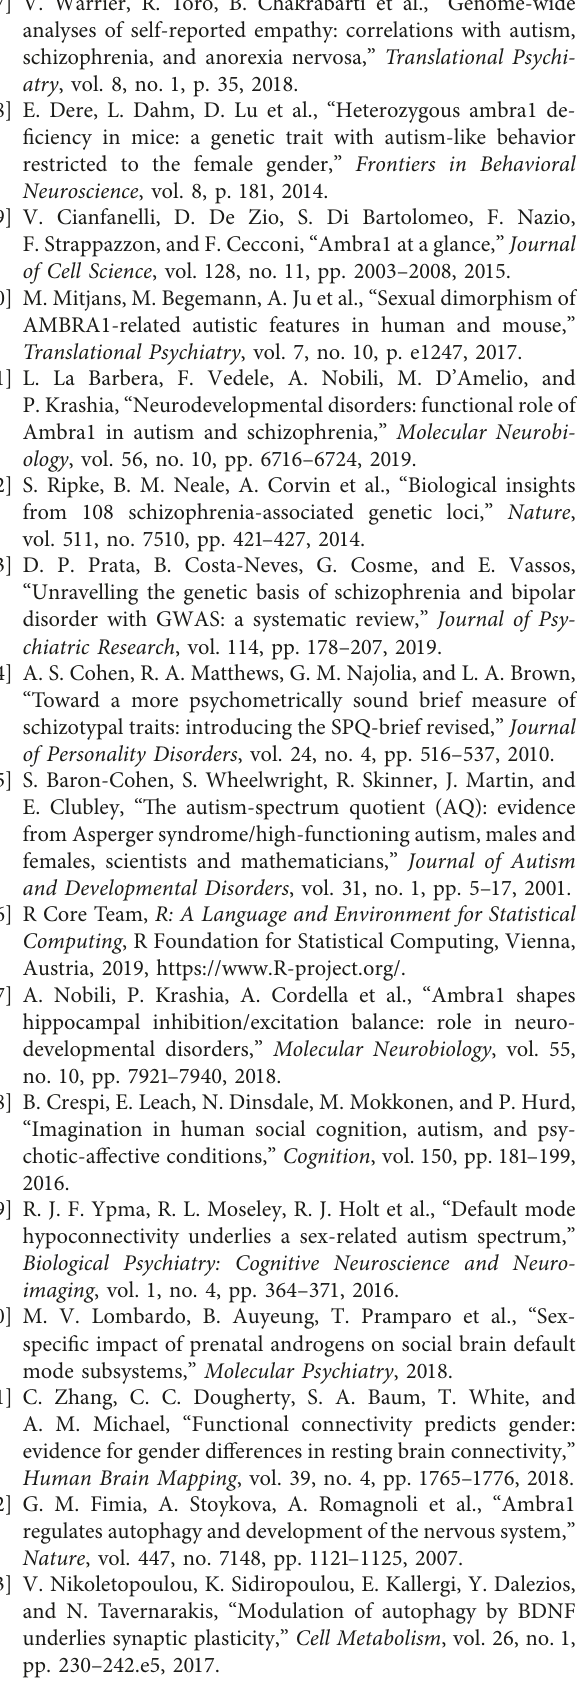
Supplementary Table 1: post hoc analysis of Autism Quo- tient and Schizotypal Personality Questionnaire variation by AMBRA1 SNP rs3802890 genotype and sex. One-way ANOVA F and p values are presented, and all df are (2, 305), with p values for the corresponding pairwise genotype comparisons. FDR adjustments were made across all 36 tests. These results are the p values from the pairwise. t .test() function in R, which compares all the groups within an ANOVA using the pooled variance (including those not in the pair). Values significant after FDR are in